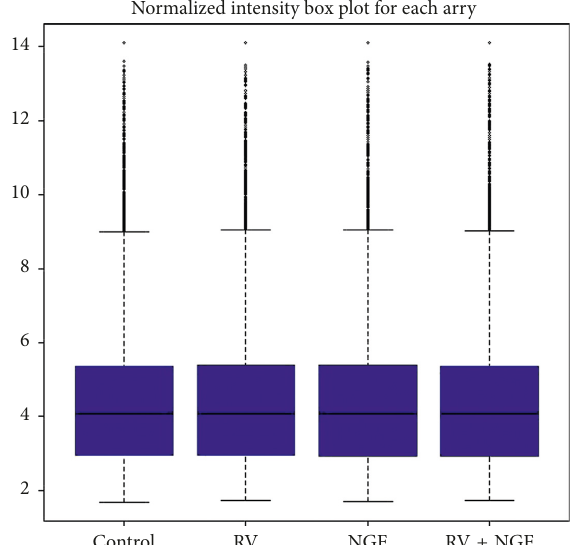
Figure 3: Box plot of microarray samples after